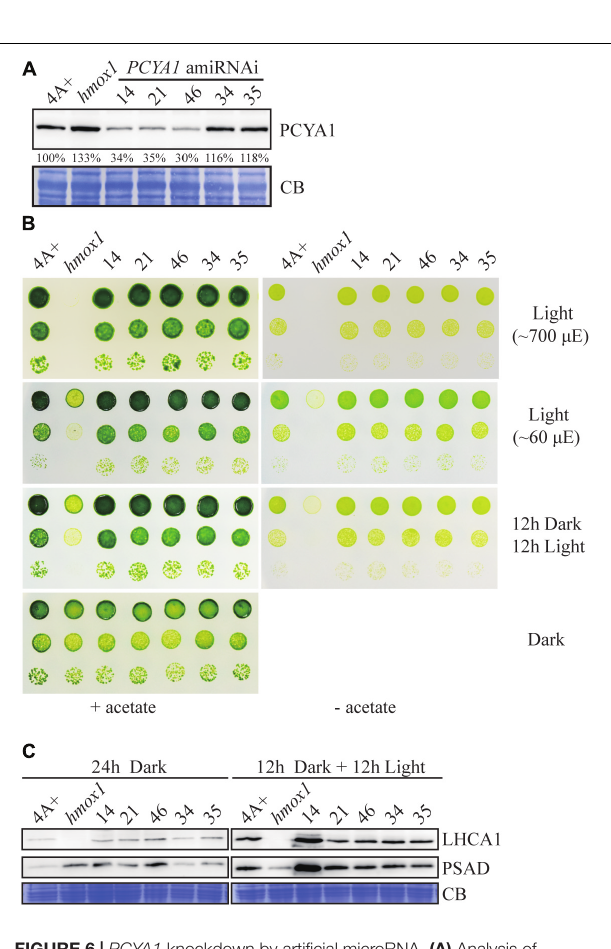
FIGURE 6 | PCYA1 knockdown by artificial microRNA. (A) Analysis of CrPCYA1 protein accumulation in artificial microRNA-mediated PCYA1 knockdown lines. (B) Phototrophic growth of PCYA1 knockdown mutants were compared with 4A+ and hmox1 under constant low light, high light